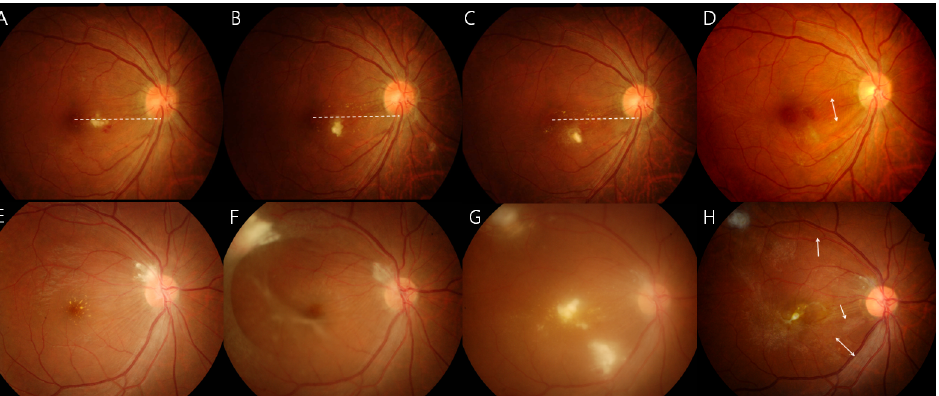
Figure 5. Continuous (A–D) and discontinuous (E–H) migration of Toxocara granuloma. (A) The granuloma shape is horizontally long, and the larva lies at the same level as the macula at the time of diagnosis. (B) Gradual inferior granuloma migration is observed. (C) The granuloma has turned toward the inferonasal side. The dotted line denotes a reference line connecting the fovea and inferior optic disc margin. (D) Retinal nerve fiber layer defect (double arrow) remains along the granuloma migration path 41 months after diagnosis. (E) Peripapillary granuloma with macular hard exudate. (F) Four months later, a new granuloma appears along the superotemporal arcade and a tractional membrane extends from the granuloma to the superotemporal vascular arcade and to the inferotemporal retina. A tractional membrane is also noted around the macula. (G) One month later, 2 novel granulomas appear in the macula and inferotemporal retina. (H) Ten months later, the inferior granuloma disappears and the macular granuloma is decreased in size, but multiple retinal nerve fiber layer defects remain (arrows).